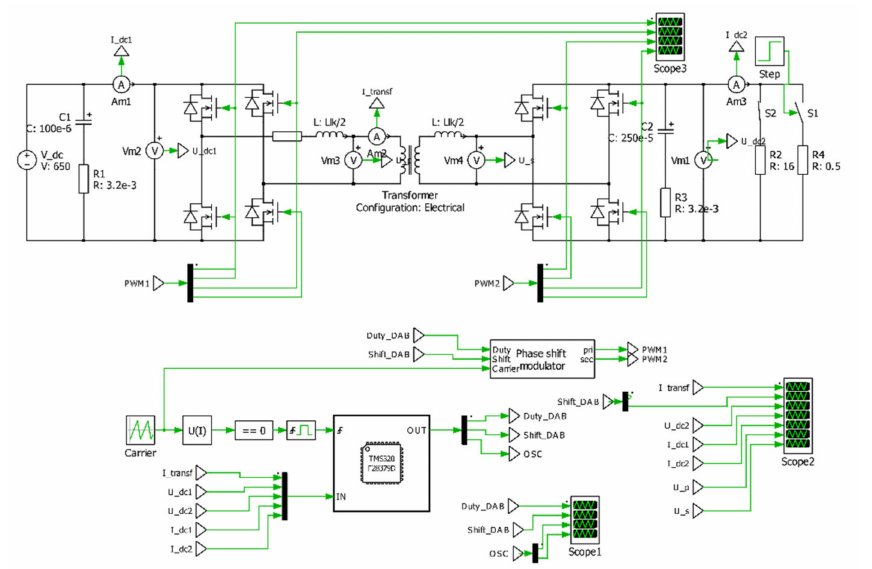
Figure 7. Simulation model of dual active bridge (DAB) converter module with a Phase Shift Controller developed in the PLECS environment.